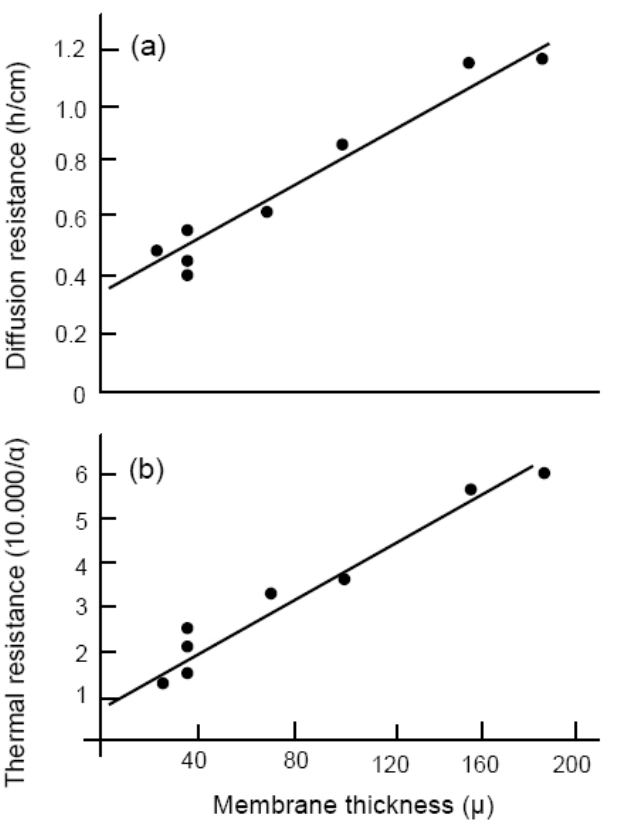
Fig. 3 Influence of membrane thickness on (a) diffusion and (b) thermal